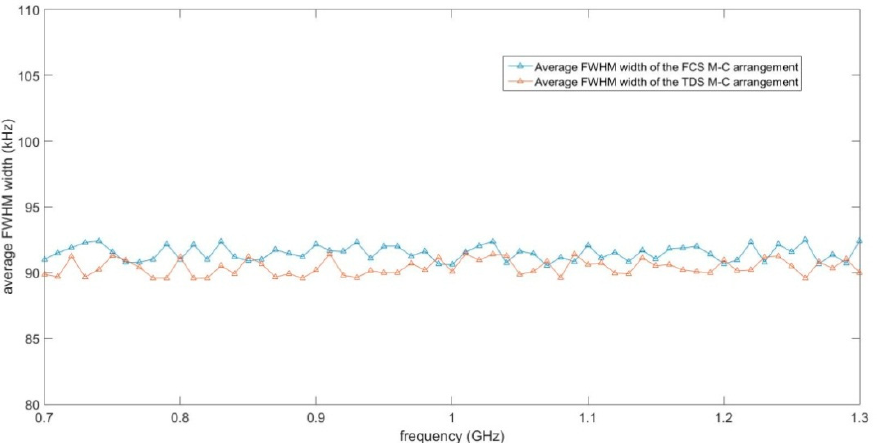
Figure 15. The calculated average full-width half-maximum (FWHM) widths of the FCS M-C arrangement and the TDS M-C arrangement. arrangement and the TDS M-C